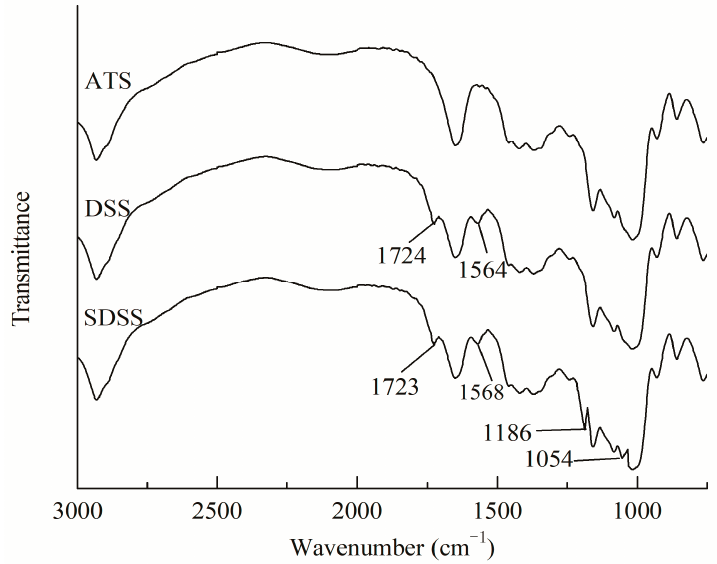
Figure 1. FTIR spectra of ATS, DSS and SDSS.